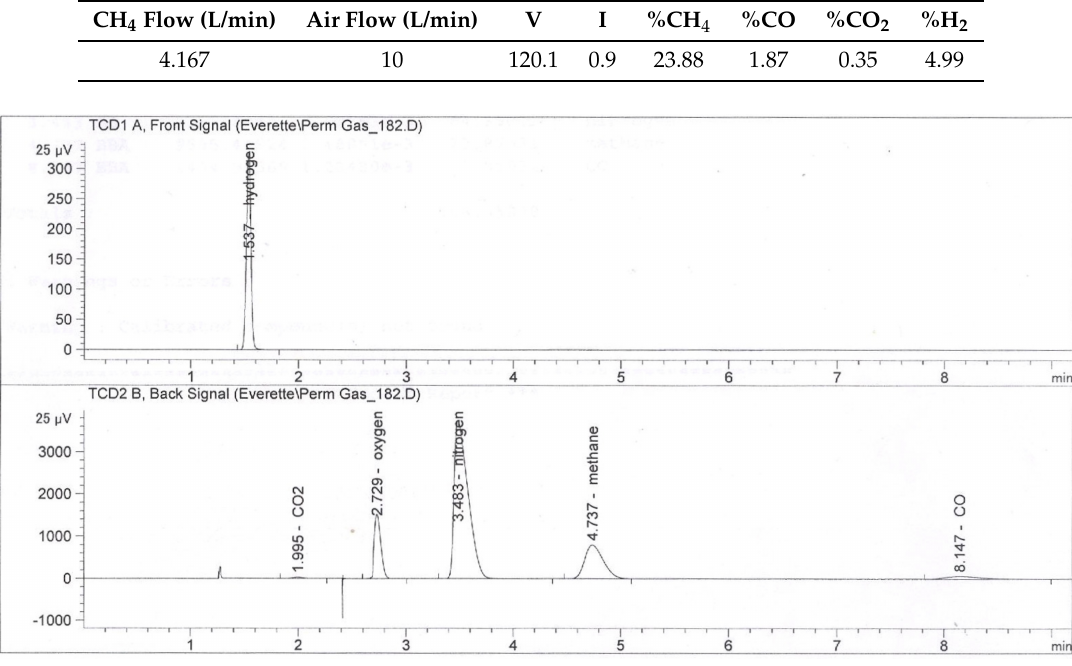
Table 1. Experimentally obtained parameters.